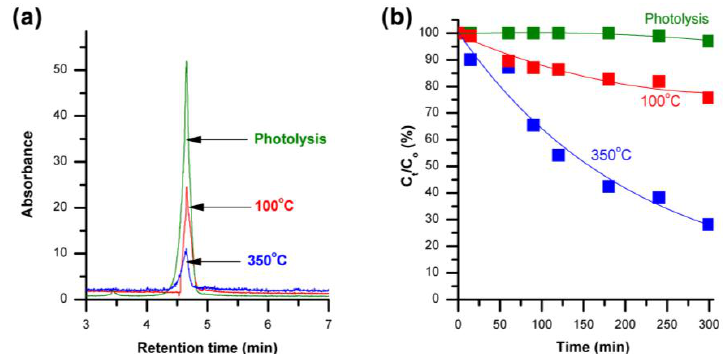
Figure 4. ( a ) High performance liquid chromatography (HPLC) chromatograms representing the phenol peak at retention time 4.66 min after 300 min of photocatalytic degradation with and without the ZnO nanorods; ( b ) Visible light photocatalytic degradation kinetics of phenol (initial concentration: 10 ppm) with and without the ZnO nanorods having different surface defect densities.